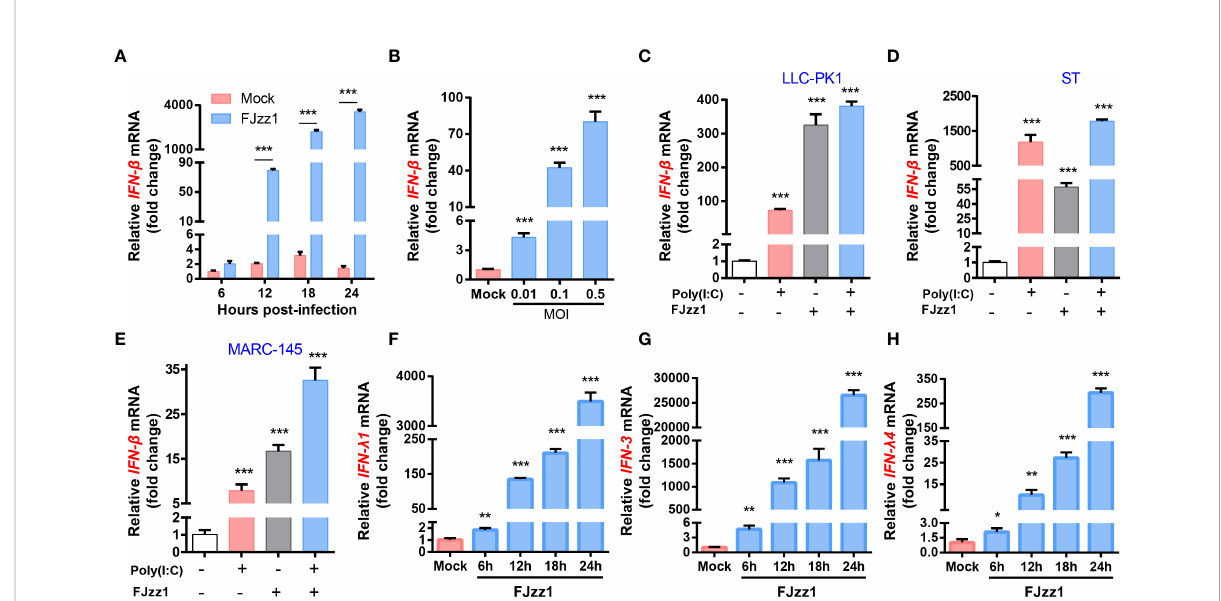
FIGURE 4 FJzz1 infection induced the production of type I and type III IFNs. (A) Transcriptional levels of IFN- b in PEDV-infected cells. LLC-PK1 cells were infected with FJzz1 at an MOI of 0.01, and total cellular RNA was prepared at the indicated times post-infection to determine the IFN- b mRNA level by RT-qPCR. (B) PEDV infection induced IFN- b production in a dose-dependent manner. LLC-PK1 cells were infected with different MOI (0.01, 0.1, 0.5) of FJzz1 for 18 h, and total mRNA was extracted to detect the IFN- b mRNA level by RT-qPCR. (C – E) PEDV infection induced IFN- b production in different cell lines. LLC-PK1 cells (C) , ST cells (E) , and MARC-145 cells (E) were infected with FJzz1 at an MOI of 0.01 for 12 h, followed by stimulation with poly(I:C) for 12 h, and total cellular RNA was extracted to detect the IFN- b mRNA level by RT-qPCR. (F – H) PEDV infection induced type III IFNs production. LLC-PK1 cells were infected with FJzz1 at an MOI of 0.01, and total cellular RNA was prepared at the indicated times post-infection to determine the mRNA level of IFN- l 1 (F) , IFN- l 3 (G) , and IFN- l 4 (H) by RT-qPCR. These data are representative of the results of at least two independent experiments and error bars represent standard deviations. Asterisks indicate statistical signi fi cance.*, P < 0.05; **, P < 0.01; ***, P <